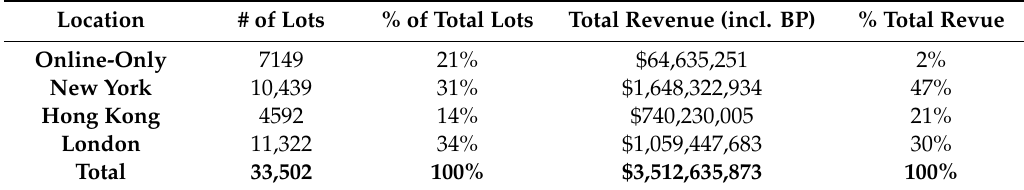
Table 1. Auction results of Christie’s New York, London, and Hong Kong (2018). Source: (Ali et al. 2019).